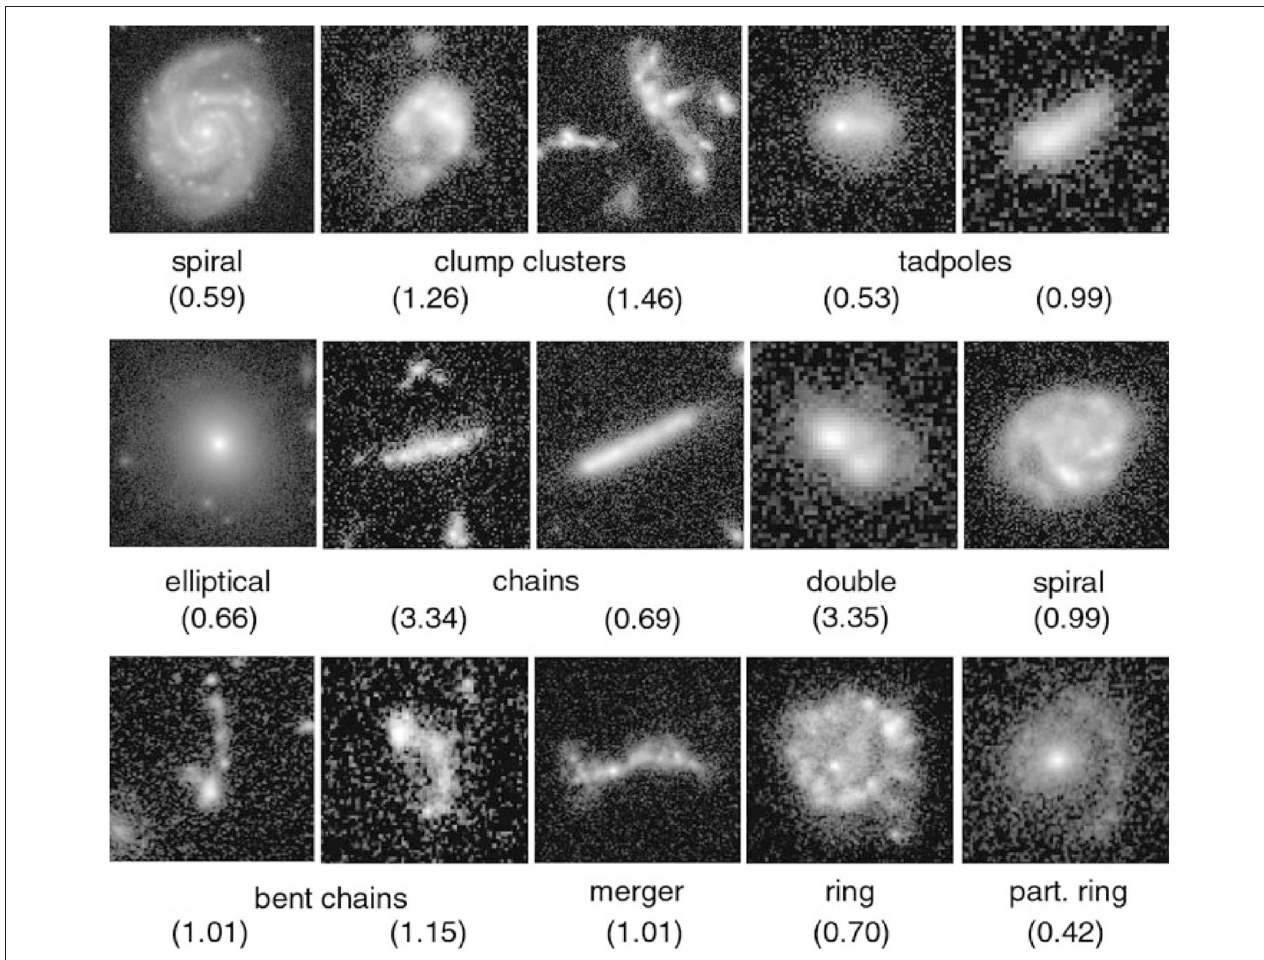
FIGURE 5 | Morphology of galaxies at intermediate and high redshift. Redshift is given by numbers in parentheses. (Credit to Buta, 2013, his Figures 1–46, from Planet and Stellar